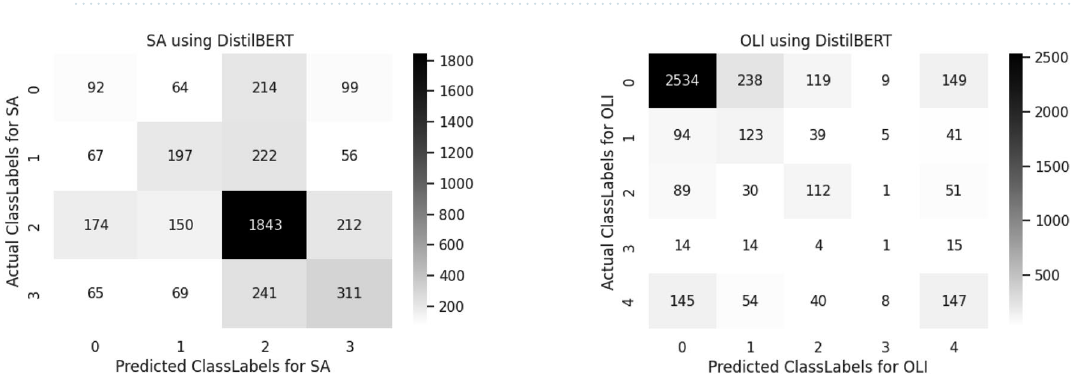
Figure 8. Confusion matrix of BERT for sentiment analysis and offensive language